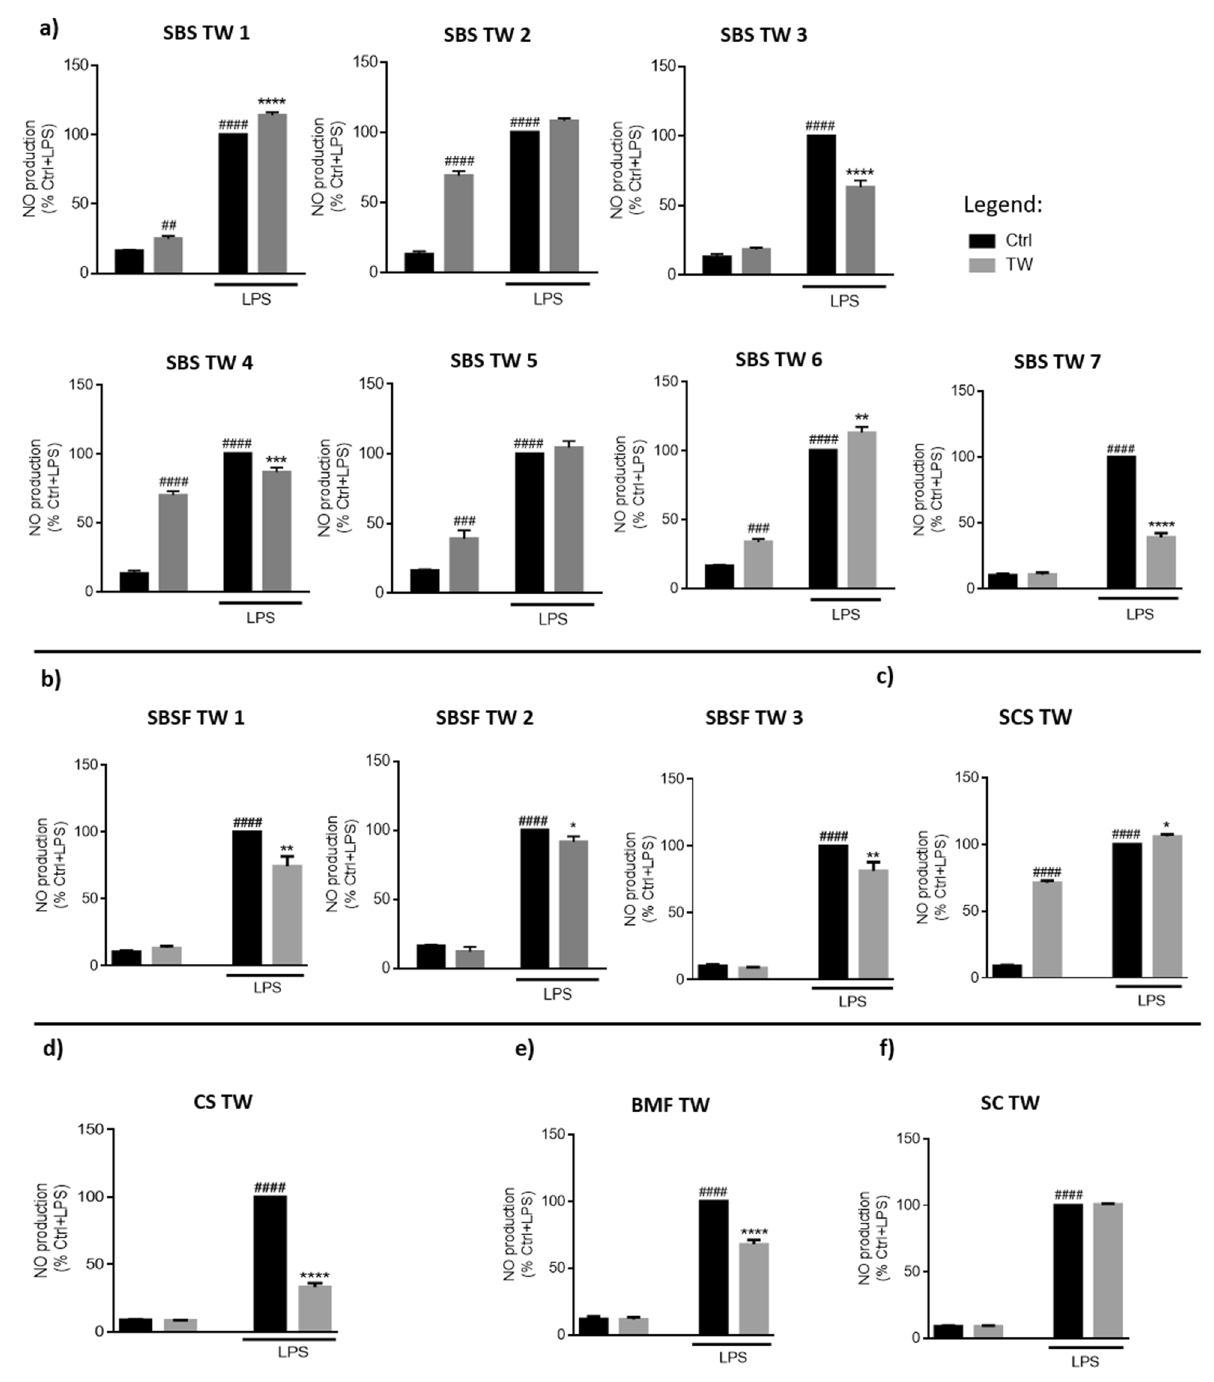
Figure 2. Thermal waters effect on macrophage NO production upon an inflammatory stimulus. Cells were plated and exposed to Ctrl medium or SBS ( a ), SBSF ( b ), SCS ( c ), CS ( d ), BMF ( e ) and SC ( f ) thermal waters (TW) for 24 h, in the presence or absence of LPS (1 µg/mL). Griess assay was performed to assess nitrites levels in the supernatant. Data correspond to the means ± SEM of at least three independent experiments and are represented as % of control (Ctrl) cells exposed to LPS (Ctrl LPS). Statistical analysis: two-way ANOVA with Tukey’s multiple comparison test; p < 0.05 was considered significant: * p < 0.05, ** p < 0.01, *** p < 0.001, **** p < 0.0001, compared to Ctrl LPS; ## p < 0.01, ### p < 0.001, #### p < 0.0001, compared to Ctrl. Legend: SBS sulphurous/bicarbonate/sodic, SBSF sulphurous/bicarbonate/sodic/fluoridated, CS chlorinated/sodic, SCS sulphurous/chlorinated/sodic, BMF bicarbonate/magnesium/ferric, SC